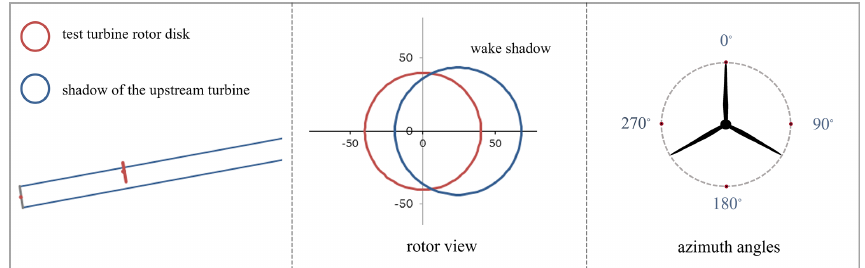
Figure 2. Wake-affected rotor area and the azimuthal